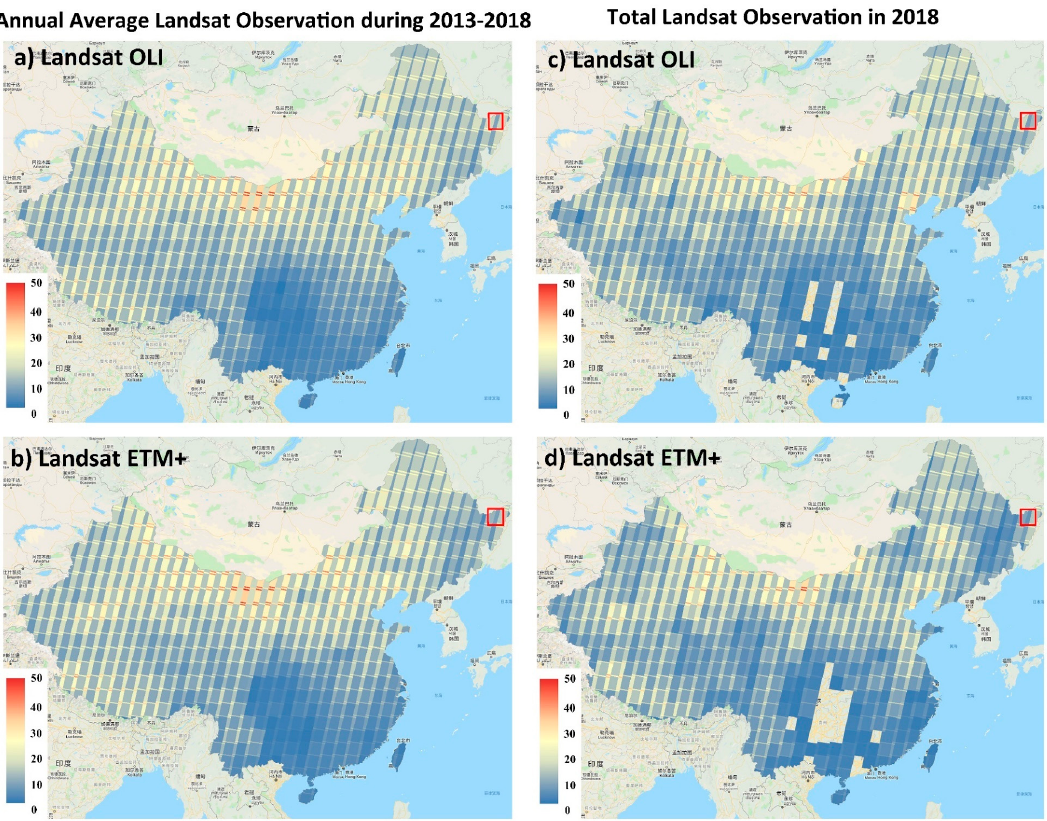
Figure 2. Availability of time series cloudless Landsat images in China. The annual average observation numbers during 2000–2018 for ( a ) Landsat 8 and ( b ) Landsat 7; the total observation numbers in 2018 for ( c ) Landsat 8 and ( d ) Landsat 7. The study area is marked with red polygons. In the study, all available Landsat 7 (ETM + ) and Landsat 8 (OLI) surface reflectance data (path / row: 114 / 27) of the study area with cloud cover less than 10% in 2018 were obtained, except for the images with large areas of snow cover in winter. The total number of qualified images is seven. All Landsat images used in the study were standard terrain-corrected (L1T), radiation-corrected, and geometric-corrected images, and had been atmospherically corrected to surface reflectance using LEDAPS (Landsat ETM + ) [36] and Land Surface Reflectance Code (LaSRC) (Landsat OLI) [37]. All possible bad observations a ff ected by clouds, cirrus clouds or ice / snow with confidence levels of 67–100% were excluded from Landsat images using the quality assessment band (QA). The SLC-o ff strips in the Landsat ETM + images were classified as “no value” [38]. Then, we cropped all images to the geographic extent of the study area. Finally, Landsat images after preprocessing were used for the STARFM and phenology-based classification (Figure 3).